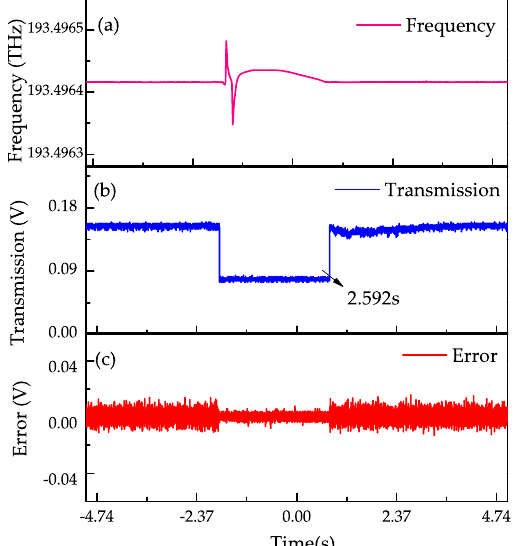
Figure 6. ( a ) Frequency signal during the relocking process; ( b ) transmission signal during the relocking process; ( c ) error signal during the relocking